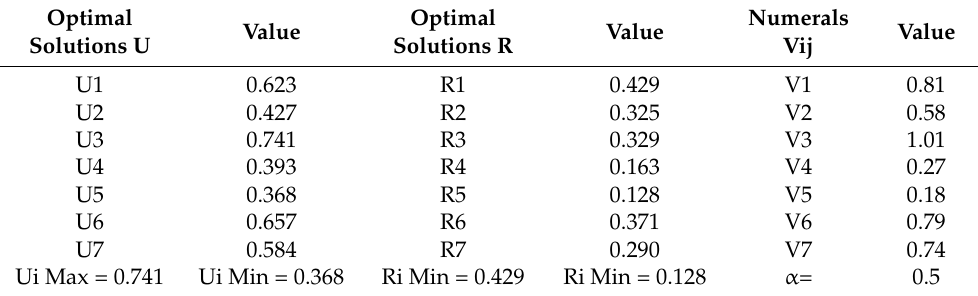
Table 10. Intermediate VIKOR